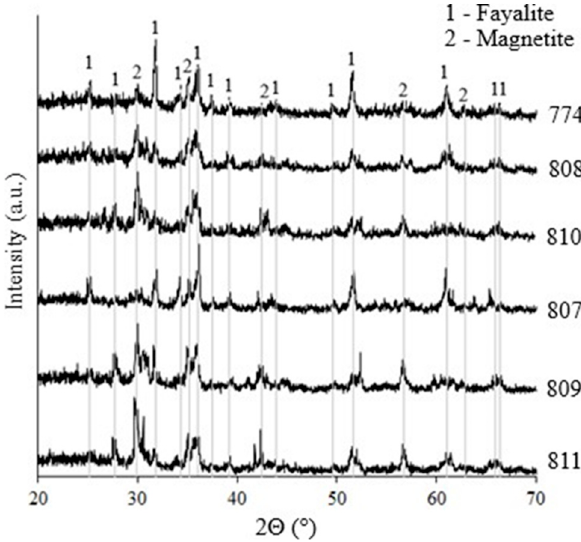
Figure 1. XRD patterns of samples of converter slag.